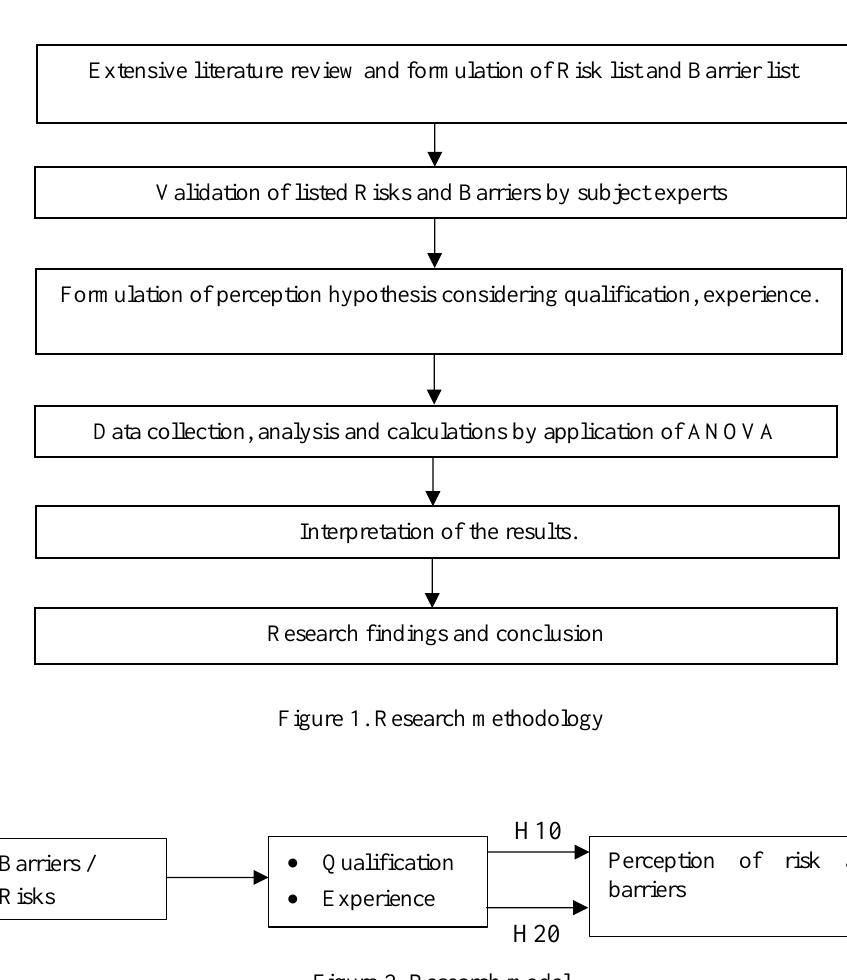
Figure 2. Research